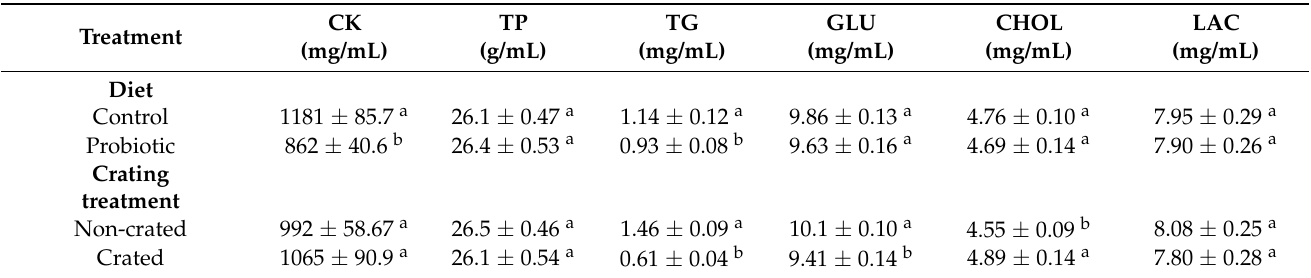
Table 4. Mean ( ± SEM) serum levels of creatinine kinase (CK) (mg/mL), total protein (TP) (g/mL), triglyceride (TG) (mg/mL), glucose (GLU) (mg/mL), cholesterol (CHOL) (mg/mL), and lactate (LAC) (mg/mL) by diet and crating treatment in ducks on day